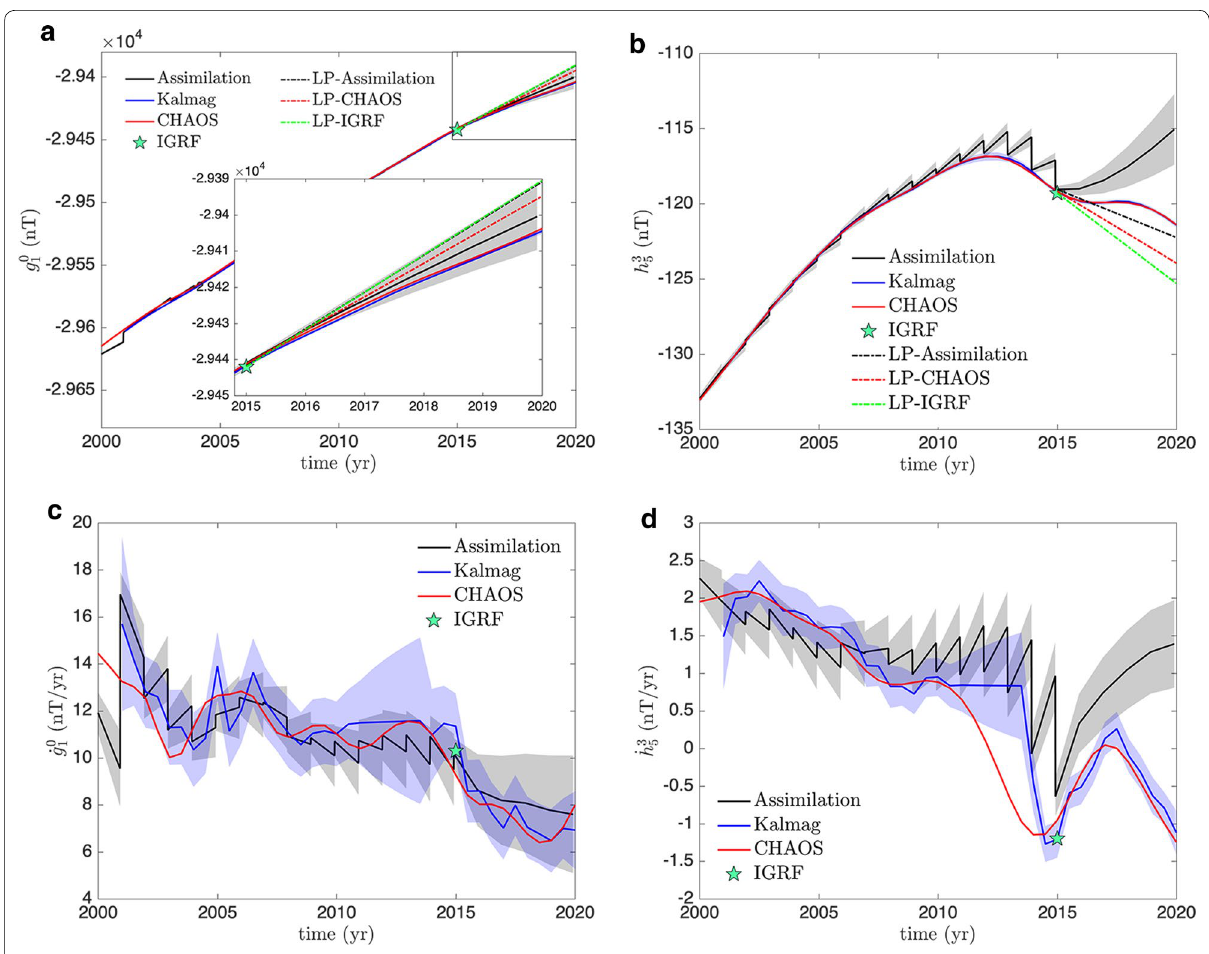
Fig. 4 Comparison of the a axial dipole g 0 1 and b h 3 5 coefficients and their respective SV c ˙ g 0 1 and d ˙ h 3 5 between an assimilation hindcast with t i = 2015 and t f = 2020 (black solid curve), the Kalmag model (blue curve), CHAOS-7 (red curve) and IGRF-12 (green star). The shaded areas represent the standard deviation of the assimilation and Kalmag model. Also shown in a and b are predictions based on the linear extrapolation (LP) of the coefficients using SV in 2015 from the assimilation (dashed black line), CHAOS-7 (dashed red) and IGRF (dashed